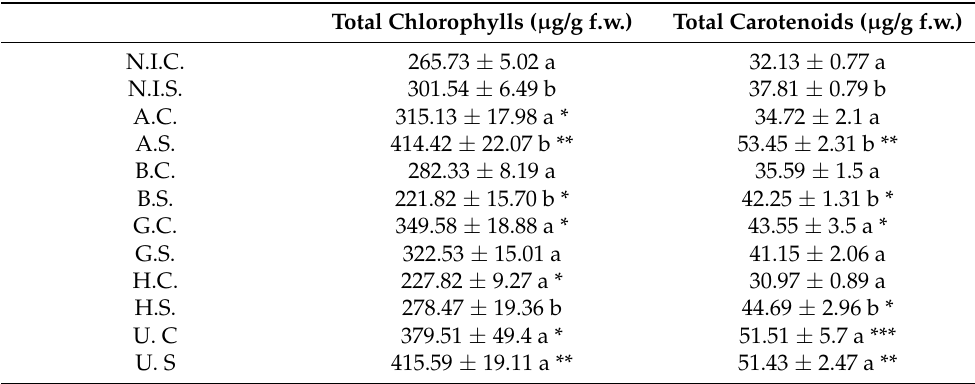
Table 3. Total chlorophyll and total carotenoid amounts of B. napus cv. SY Saveo grown for 30 days on non-saline soil (C) or saline soil (S). Plants were inoculated with plant growth-promoting bacteria (A = A. brasilense , B = B. ambifaria , G = A. globiformis , H = H. seropedicae , U = Pseudomonas sp. UW4) or not (N.I. = non-inoculated). Different letter means significant difference within the same bacterial treatment. Significant differences between inoculated or non-inoculated plants grown at the same soil conditions are marked as * ( p < 0.05), ** ( p < 0.01) or *** ( p < 0.001) ( n = 9). Total Chlorophylls ( µ g/g